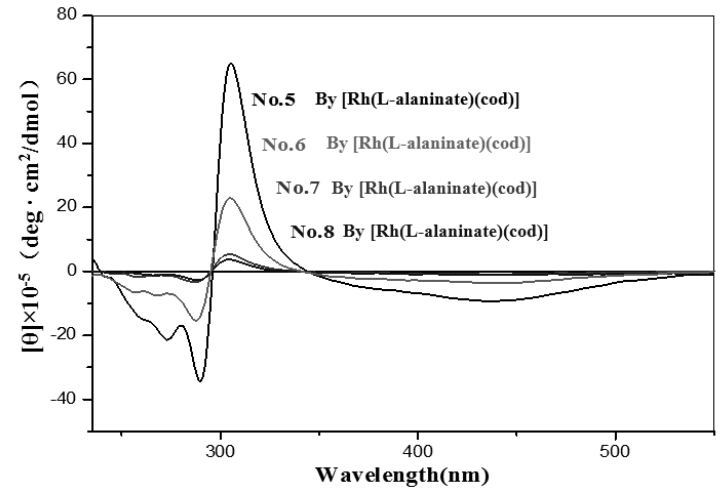
Figure 3. CD spectra of chiral poly( DoDHPA ) obtained using the [Rh(cod)Cl] 2 /(chiral amine) catalytic system (CD spectra were determined in a THF solution with 1.000 mmol/L poly( DoDHPA )) (Table 1, entries 1 – 4).